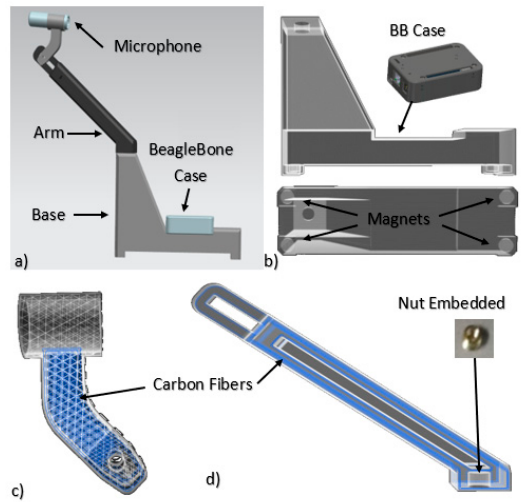
Figure 4. ( a ) Isometric view 3D printed assembly; ( b ) base lateral and bottom views; ( c ) pivot; and ( d ) arm.